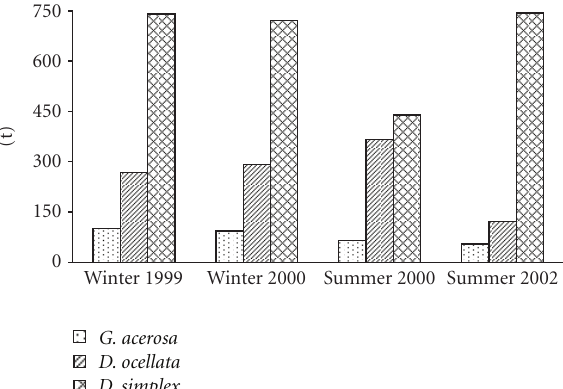
Figure 2: Biomass variation of the most representative macroalgae species, Gelidiella acerosa , Dictyosphaeria ocellata, and Digenea simplex , on the entire reef flat. The values correspond to the mean of the 10 sites